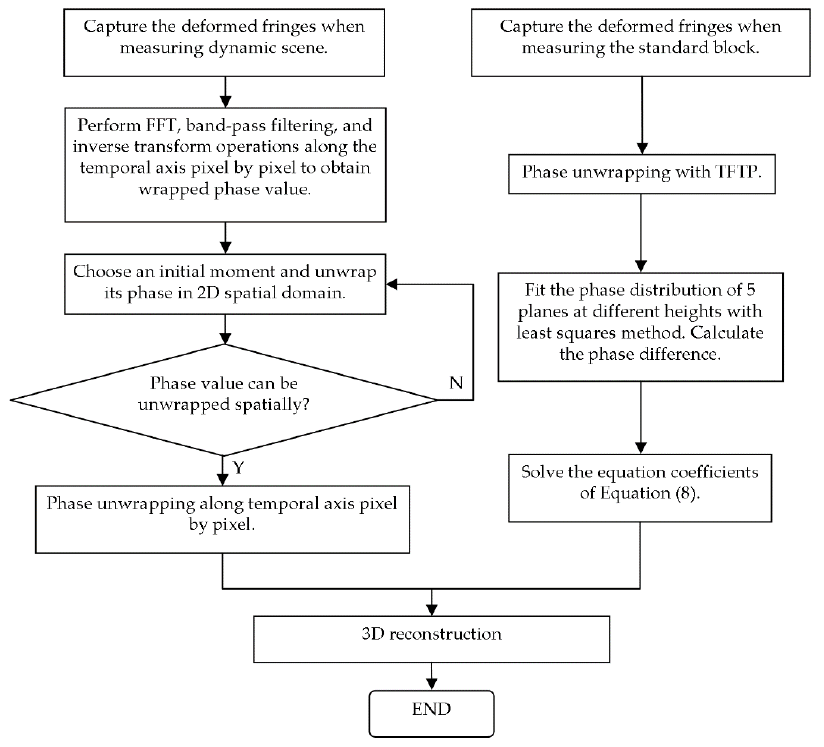
Figure 4. Flow diagram of this proposed method.